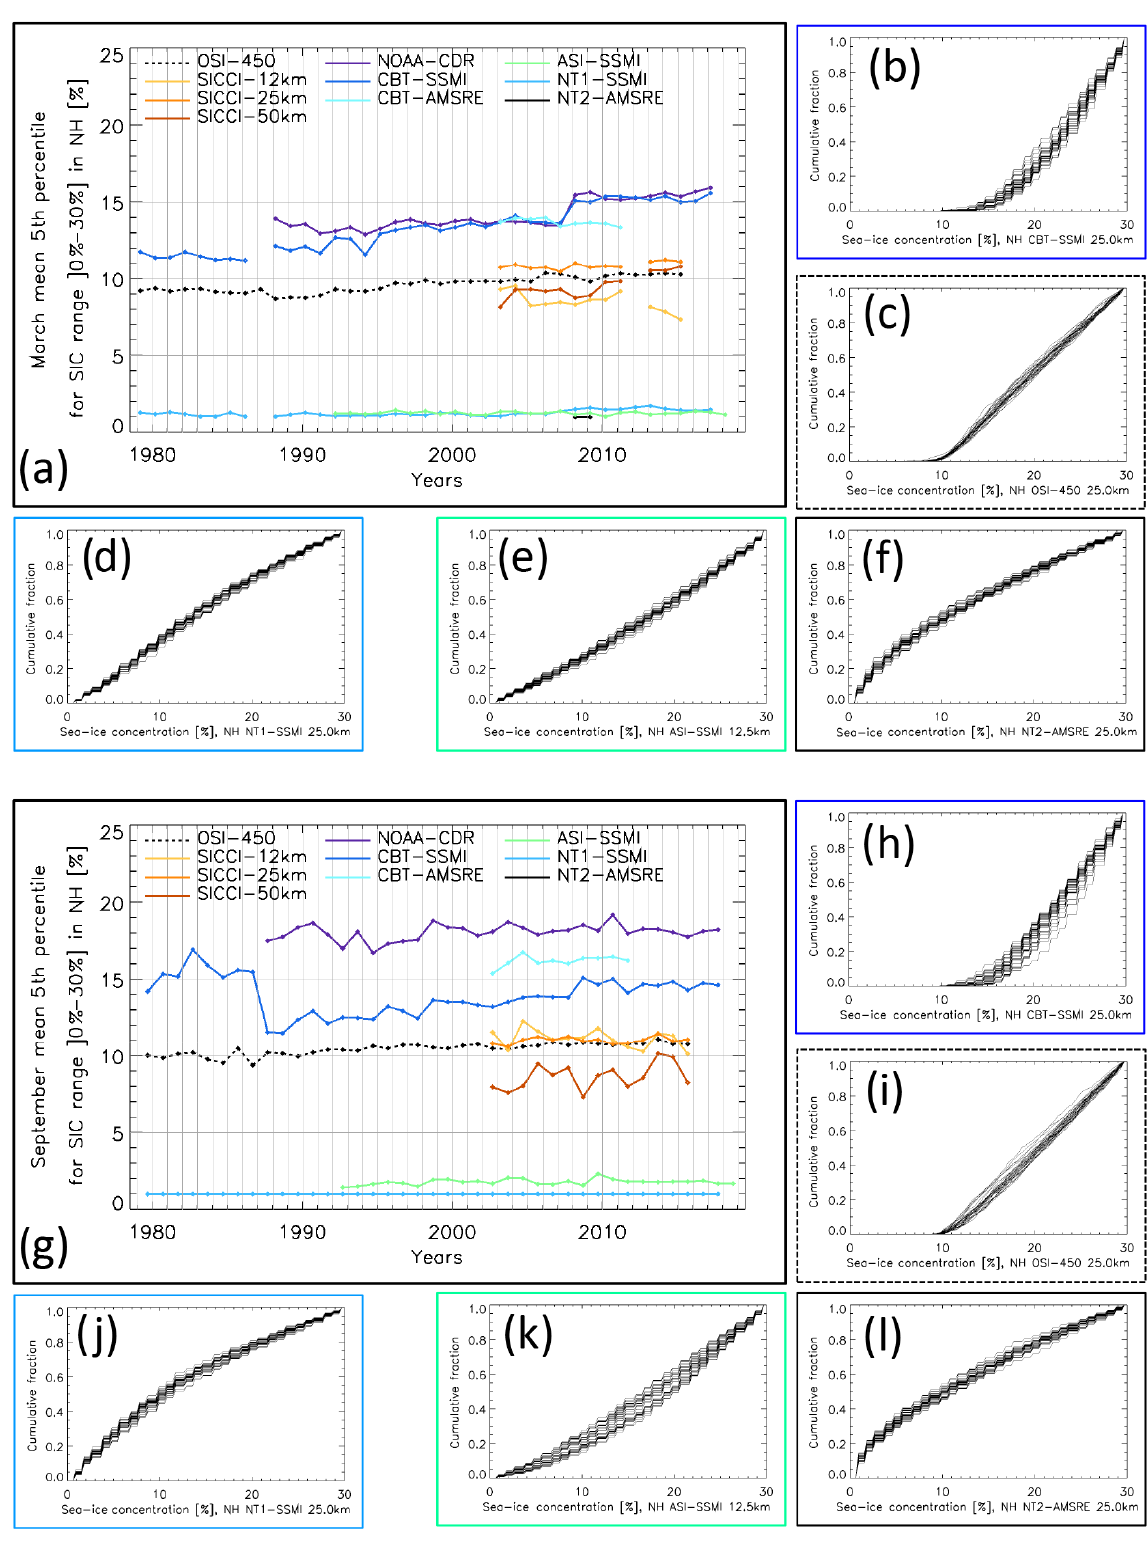
Figure 1. Time series of the monthly mean 5th percentile sea-ice concentration of the range ]0.0% to 30.0%] for the Arctic in (a) March and (g) September for all 10 products. Panels (b–f) and (h–l) show daily cumulative sea-ice concentration distributions of five selected products in these two months, respectively, in a sample year: 2004. See Table 2 for the time periods with data from the respective products.